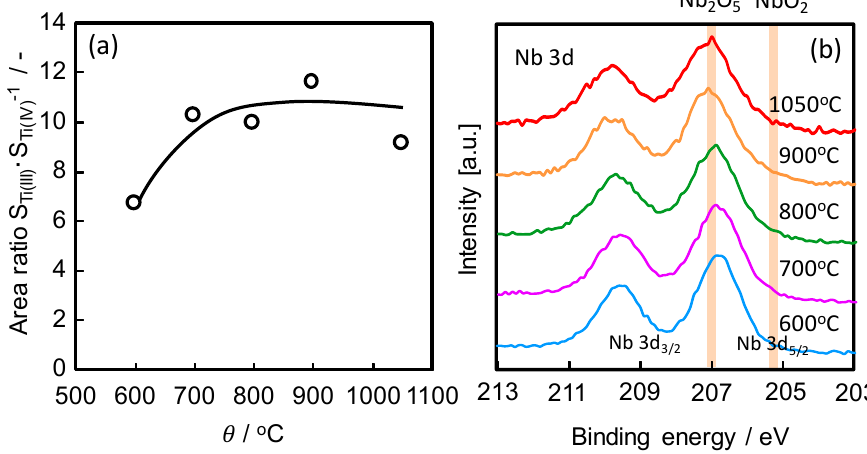
Figure 5. ( a ) Dependence of the ratios of Ti 3+ /Ti 4+ , S Ti(III) / S Ti(IV) , calculated from areas of the XPS spectra of the specimens heat-treated under reductive atmosphere on the temperature. ( b ) Nb 3d XPS spectra of the catalysts prepared at 600, 700, 800, 900, and 1050 °C in Ar containing 4% H 2